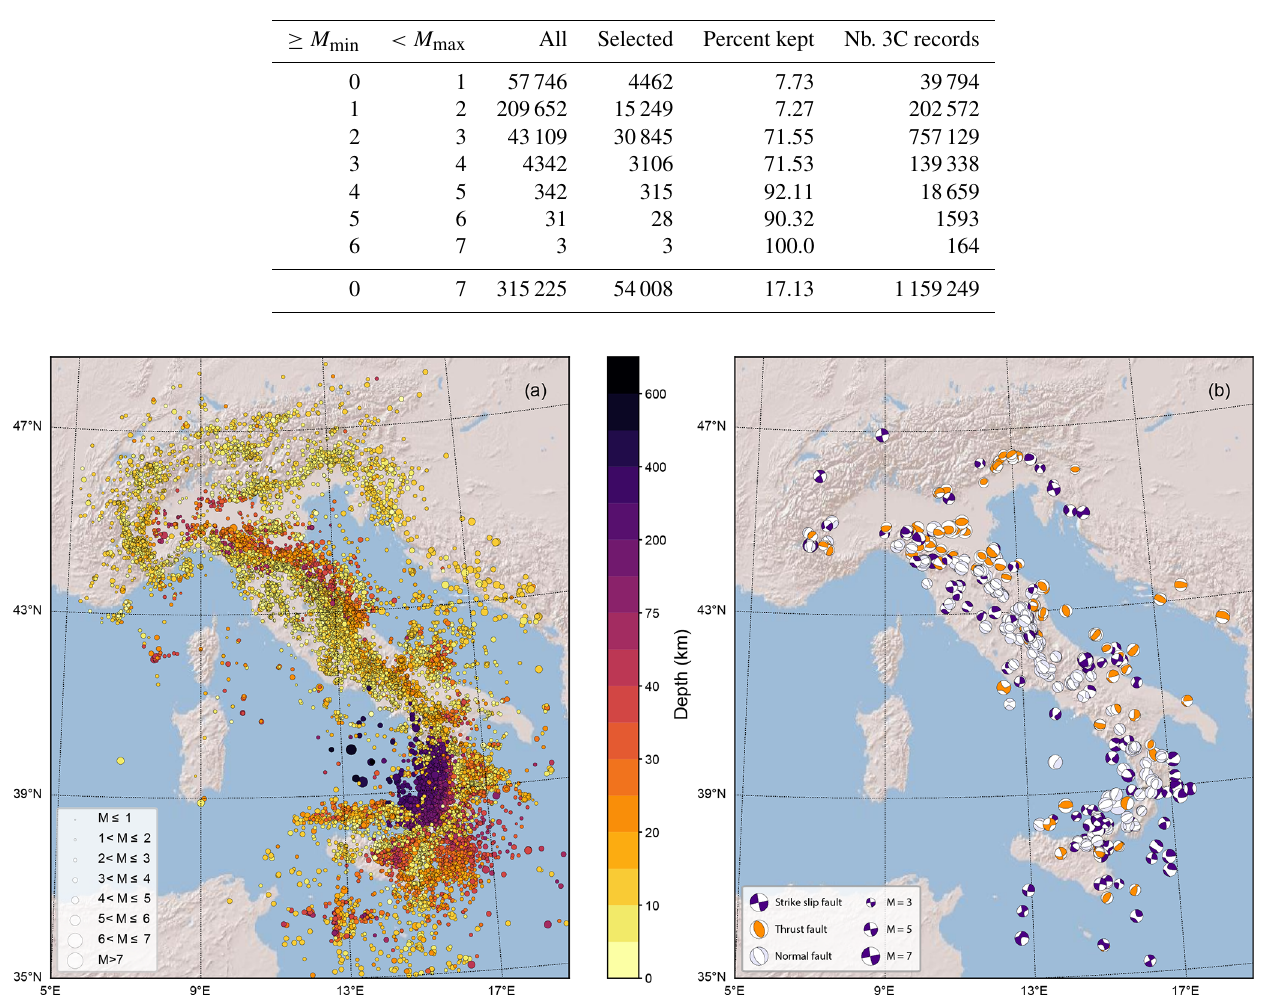
Figure 1. Map of the earthquakes included in the dataset shown as solid circles with colors selected according to depth (a) , and map of the available moment tensors with colors assigned depending on the focal mechanism (b) . Symbol size, in both maps, is proportional to earthquake